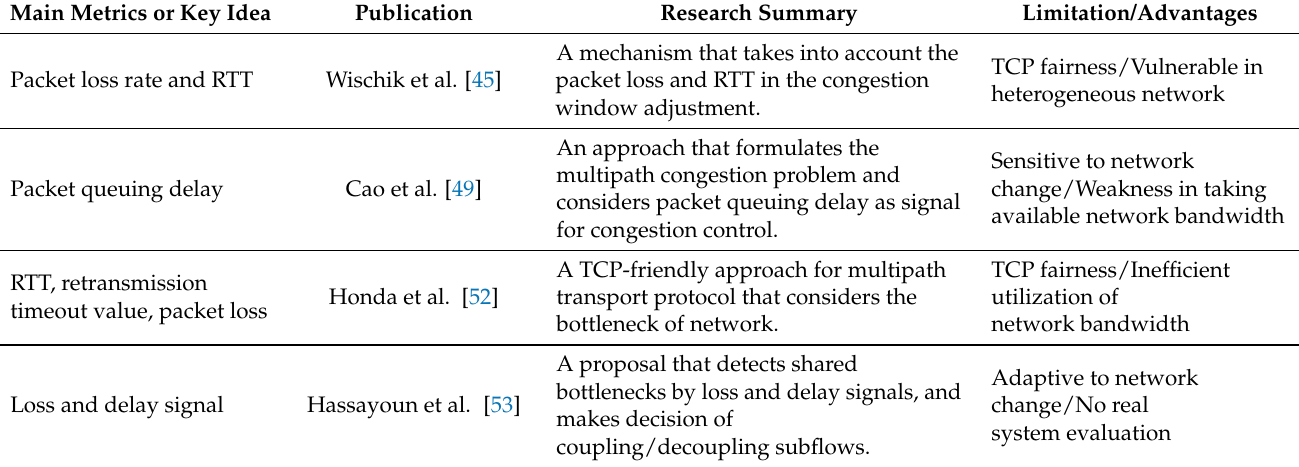
Table 2. Studies on MPTCP congestion